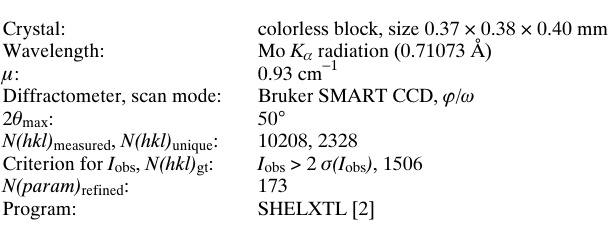
Table 1. Datacollection and handling.